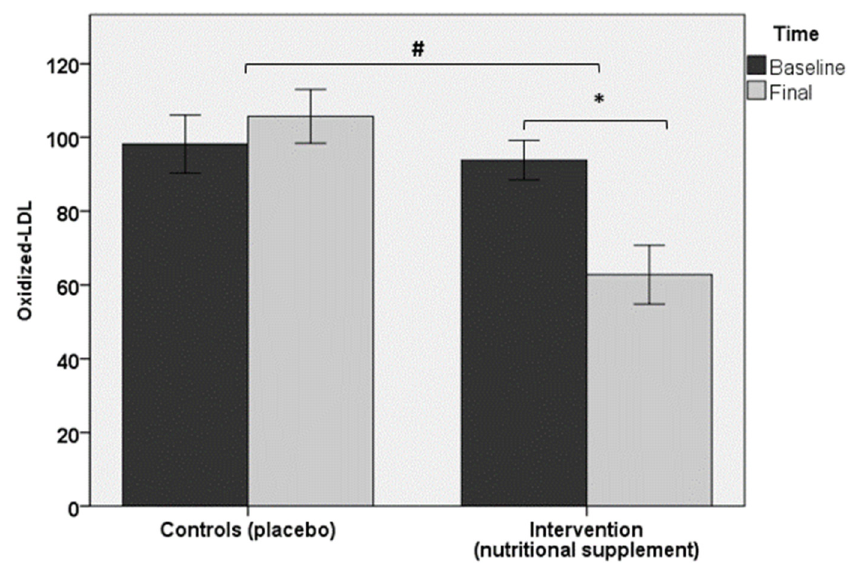
Figure 2. Between-group differences ( p < 0.05) in the intervention group in ox-LDL values at the end of the study (90 days) as compared with baseline (* asterisk); within-group differences were also significant ( p < 0.05) (# number sign).